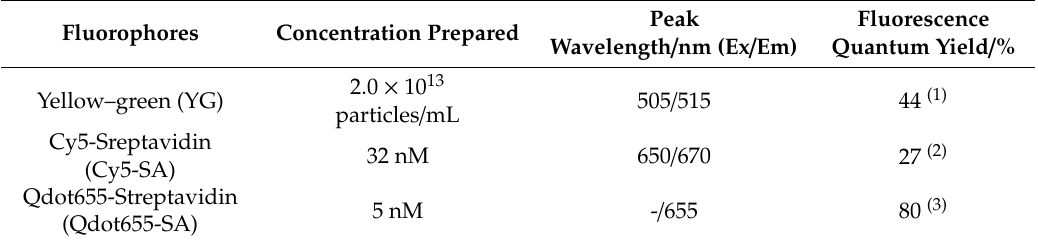
Table 2. Preparation and fluorescence characteristics of particle.